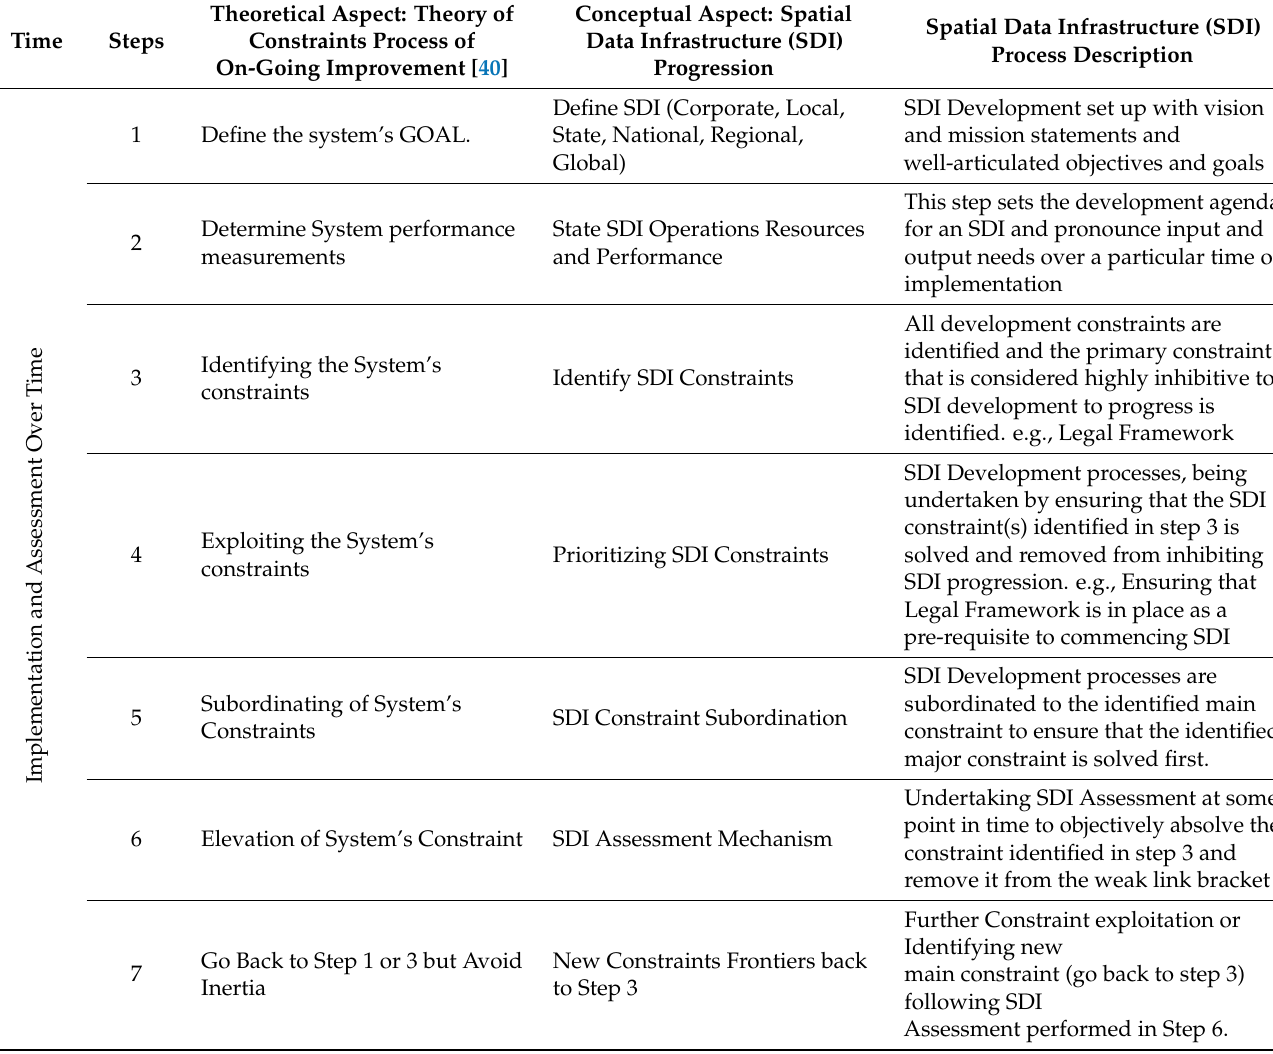
Table 2. The SDI on-going improvement (SDIOGI) proposal (Maphale, 2019)